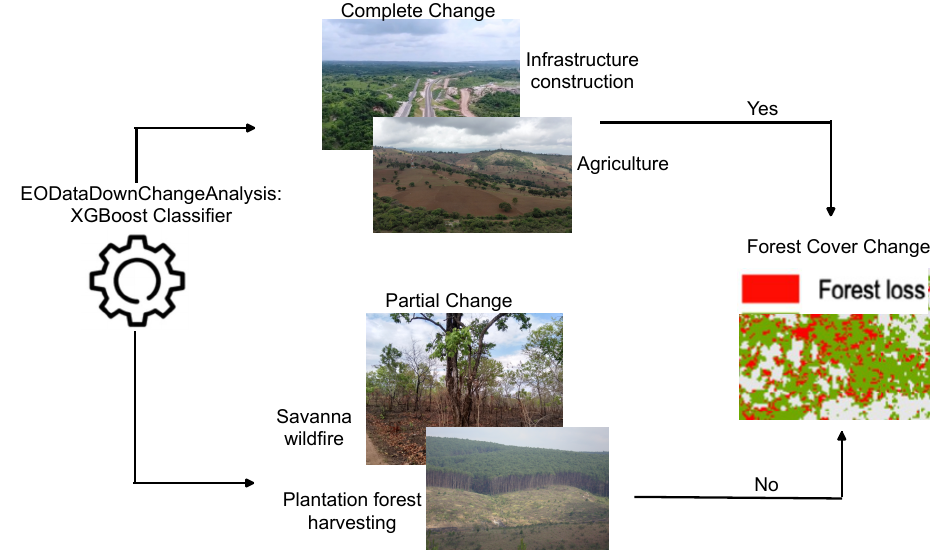
Figure 4. A flowchart of of forest change detection